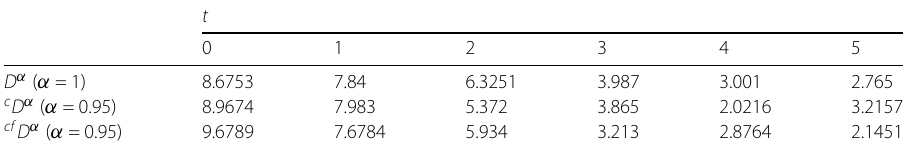
Table 3 Comparison between the standard derivative, Caputo fractional derivatives, and Caputo–Fabrizio fractional derivative for I ( t ) t